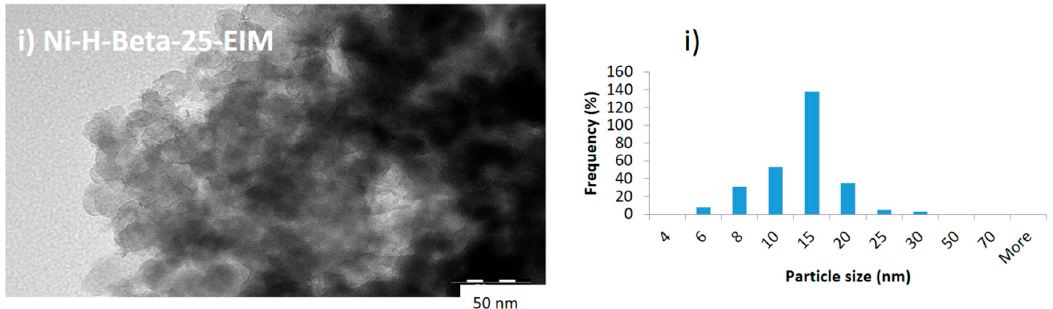
Figure 1. Transmission electron microscope (TEM) images and Cu, Pd, Fe, Sn, Ni particle size distribution histograms of Cu-H-Beta-25-IE, Cu-H-Beta-150-IE, Cu-H-Beta-300-IE, Cu-H-Beta-150-EIM, Cu-H-Beta-150-DP, Cu-Na-Mordenite-12.8-IE, Pd-H-MCM-41-EIM, Fe-SiO 2 -DP, and Ni-H-Beta-25-EIM ( a – i ).